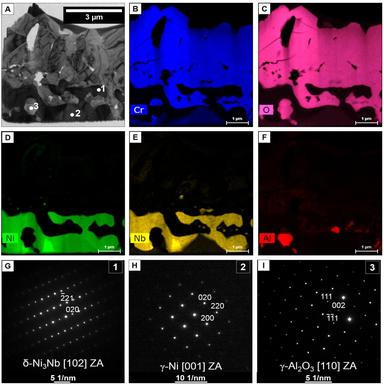
(A) TEM-BF image of oxide scale formed on the 718Plus superalloy (850 °C, 1000 h); (B–F) STEM-EDXS distribution maps of selected elements; (G–I) Electron diffraction patterns for areas 1-3 in A.